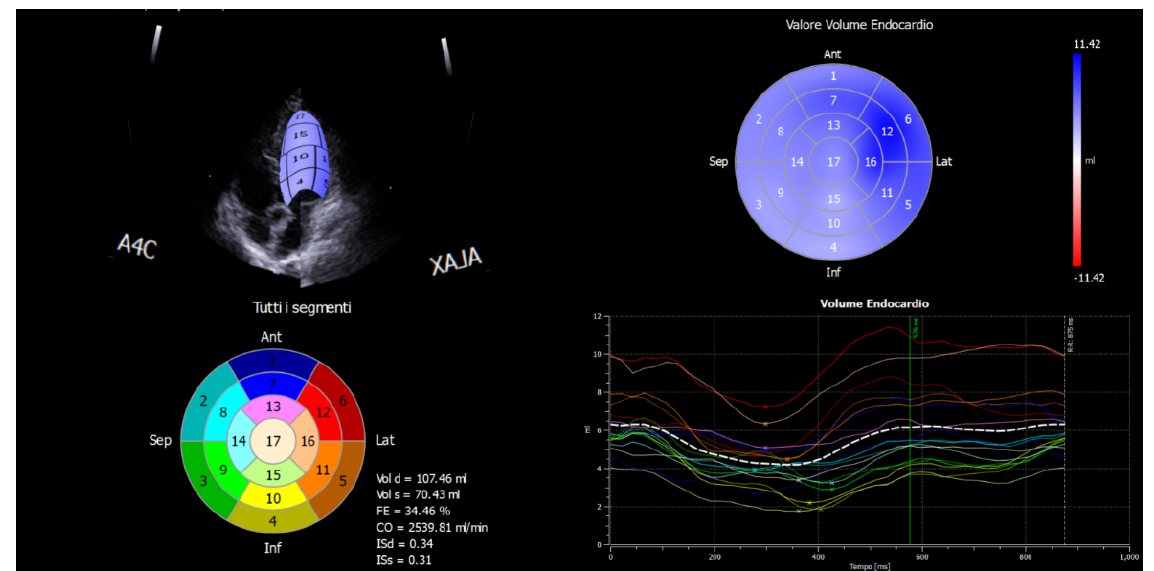
Figure 1. Example of strain analysis and reconstruction by X ‐ Strain software. The single chamber deformation segments are associated with different colored lines and reported in the circle by numbers that define the exact anatomical origin. Each colour corresponds to the deformation of a single myocardial segment. The minus sign ( − ) on the figure corresponds to the deformation values (strain). A4C= Global longitudinal strain 4 chambers; ALAX= Global longitudinal strain 3 chambers; Ant= Anterior wall; Lat= Lateral wall; Inf= Inferior wall; Sep= Septal wall.